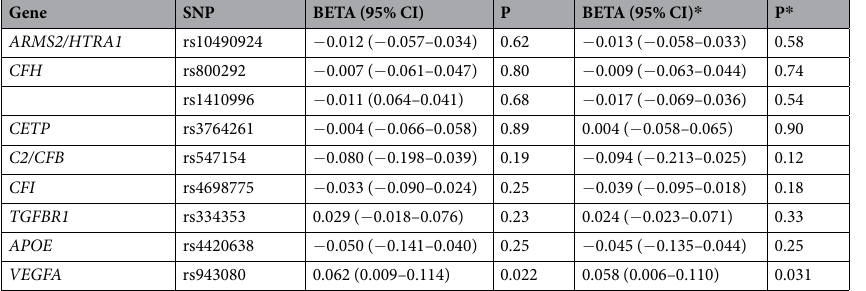
Table 3. Associations of 9 single nucleotide polymorphisms in 8 age-related macular degeneration susceptibility genes with visual acuity change during 12 months of ranibizumab treatment in the discovery stage. * Adjusted for age and sex, SNP: single nucleotide polymorphism, OR: odds ratio, CI: confidence interval.